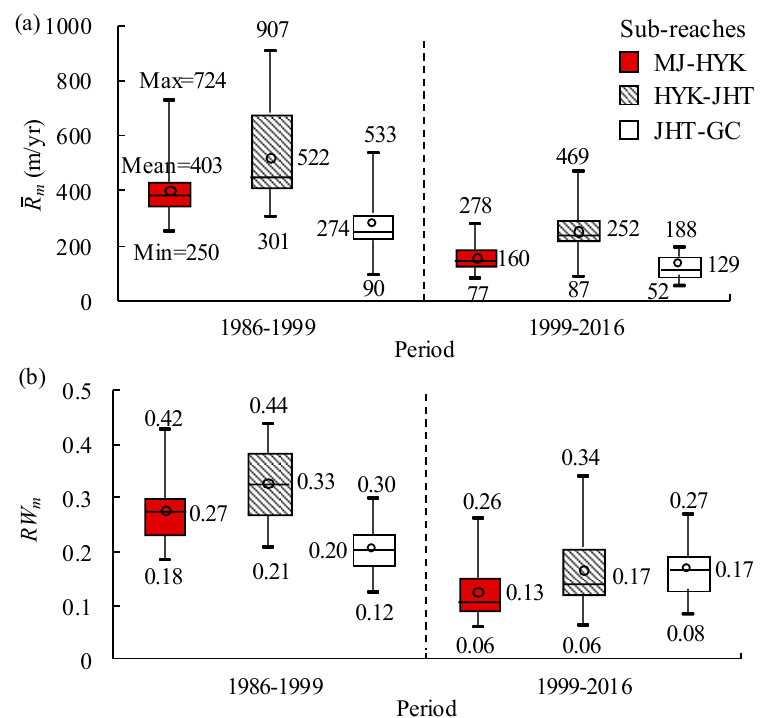
Figure 12. Temporal variations in the reach-scale migration parameters of channel centerline in three sub-reaches: ( a ) rate; ( b ) intensity.